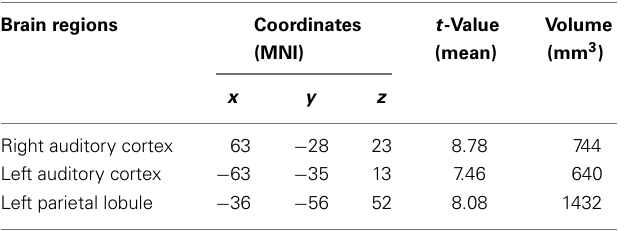
Table 1 | Experiment 1 regions of interest identified by interaction effect of name condition (SON, FN, UN) and baseline (EO, EC).